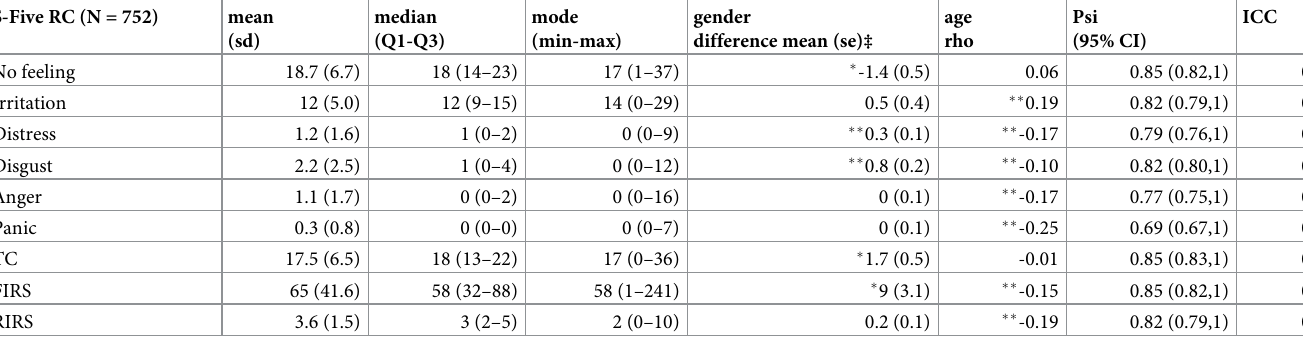
Table 4. Norms and reliability of the S-Five-T scores.